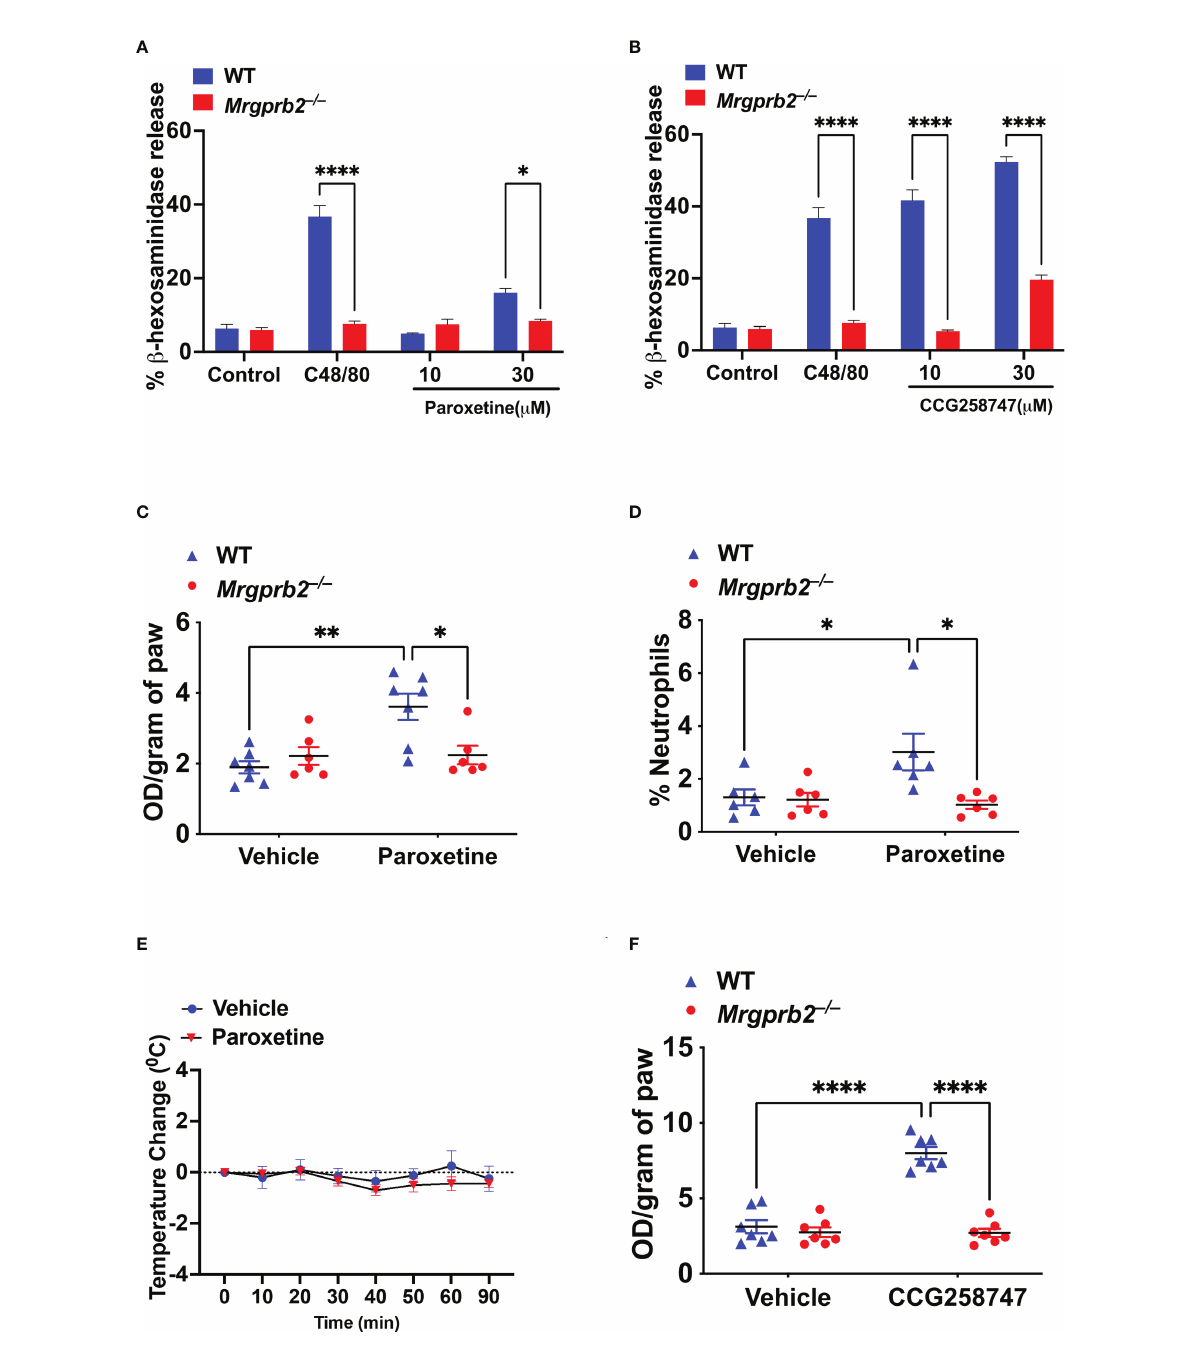
FIGURE 4 Paroxetine and CCG258747 activate murine MCs in vitro and in vivo via MRGPRB2. WT and Mrgprb2 − / − PMCs were stimulated with (A) C48/80 (10 µg/mL) and paroxetine (10 and 30 µM), or (B) C48/80 (10 µg/mL) and CCG258747 (10 and 30 µM), and b -hexosaminidase release was measured. WT and Mrgprb2 − / − (n = 6-7) mice were intradermally injected with paroxetine (0.1 mg/kg, 30 µL, 30 min), (C) Evans blue dye extravsation and (D) neutrophil recruitment was measured. (E) Paroxetine (5 mg/kg, 100 µL) or PBS control was injected intraperitoneal in WT (n=5) mice to assess systemic anaphylaxis via rectal temperature drop from baseline. (F) Evans blue dye extravasation with intradermal injection with CCG258747 (0.1 mg/kg, 20 µL, 30 min). Error bars are standard error of mean (SEM) and signi fi cant differences were set at *p ≤ 0.05, **p ≤ 0.01 and ****p ≤